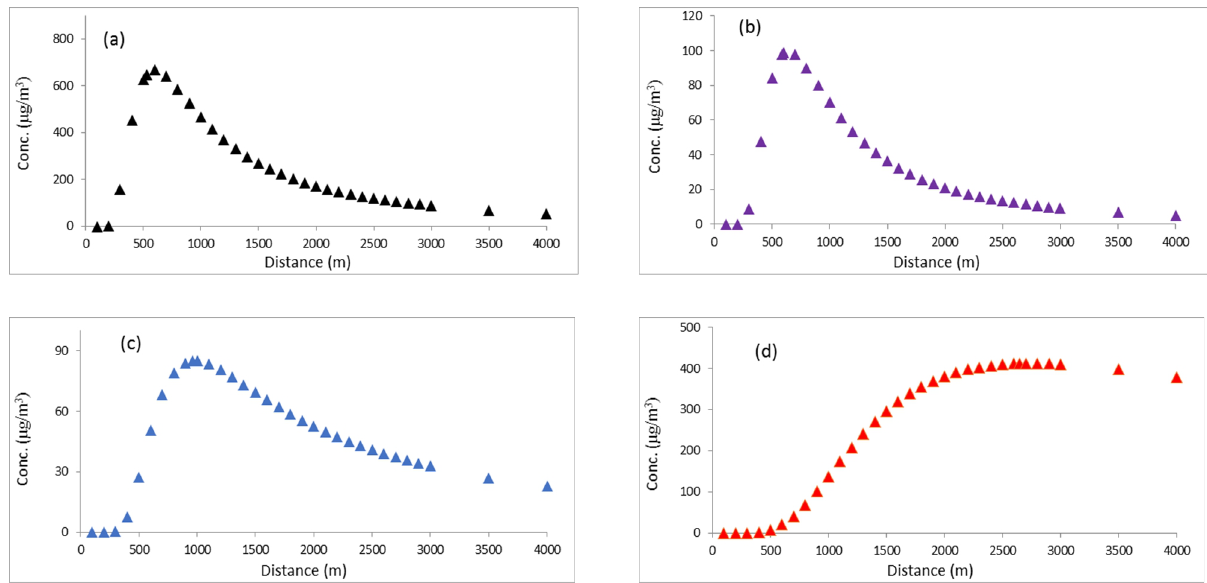
Figure 3. Dispersion of CO at different distances of cement plant (a) spring, summer, fall, and